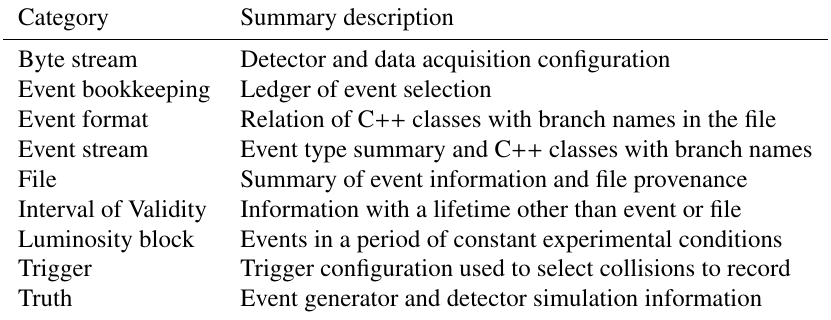
Table 1. The ATLAS in-file metadata may be separated into ten categories. Each category uses one shared object to contain information. Multiple instances of such objects may and often do exist. Each category is managed by a dedicated